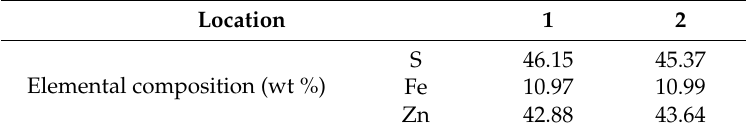
Figure 4. Surface image of sphalerite obtained by scanning electron microscopy (SEM) and locations to be analyzed by energy dispersive X-ray spectroscopy (EDS). Table 3. Energy dispersive X-ray spectroscopy (EDS) analysis results of the locations shown in Figure 4.